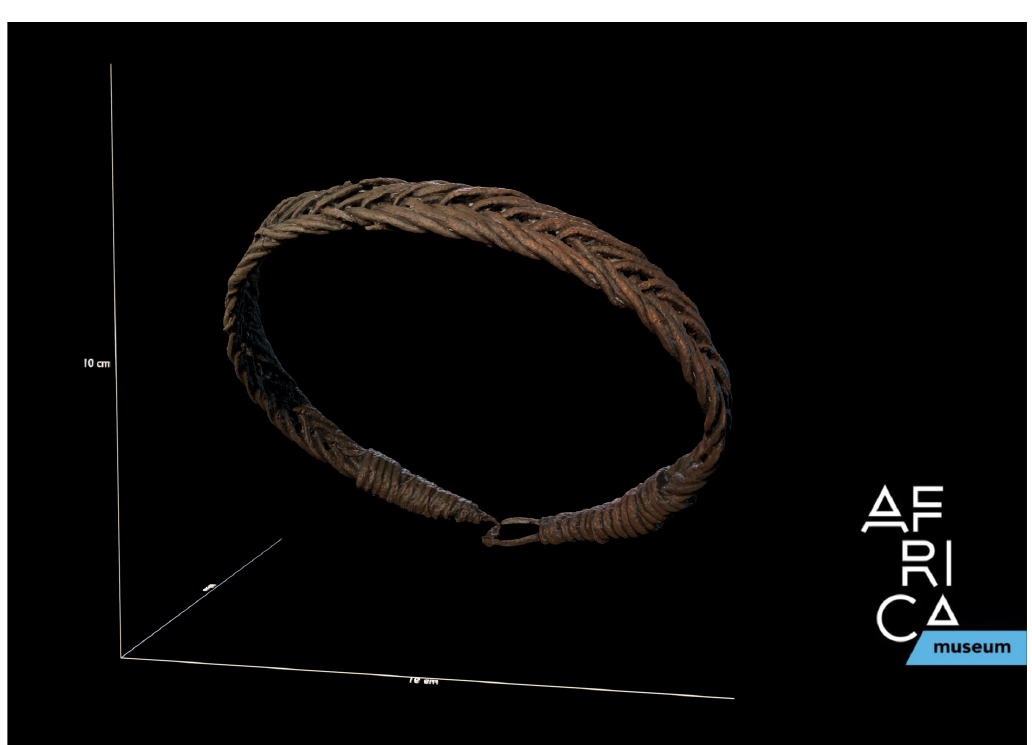
Fig. 3.7. Example of a photogrammetry model of an archaeological copper necklace from DRCongo https://sketchfab.com/models/122d9a4660a24f5181bc586672c9ffe3